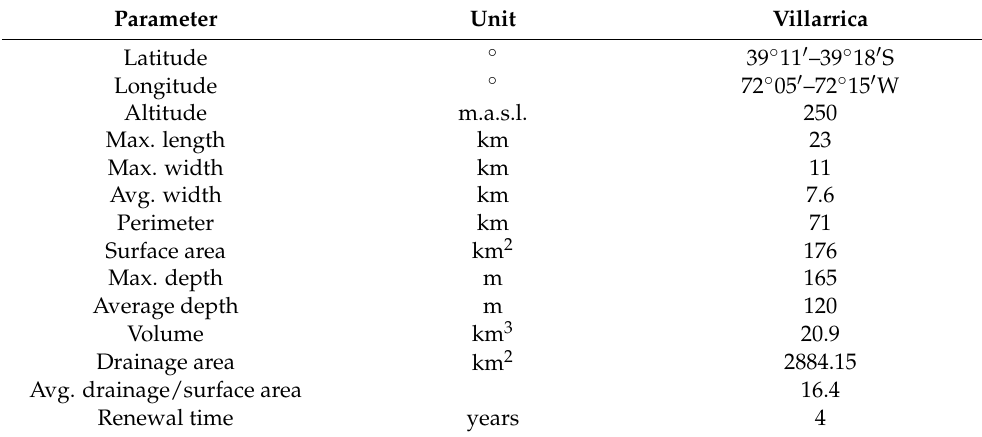
Table 1. Morphometric characteristics of Lake Villarrica.